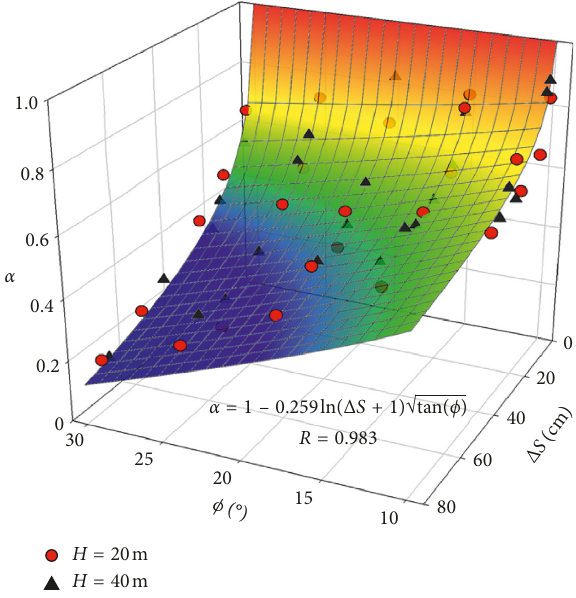
Figure 6: Fitting surface of unloading coefficient α